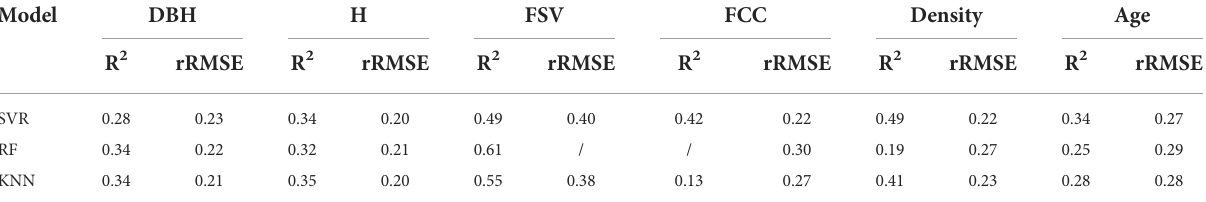
TABLE 7 The R 2 and rRMSE of the estimated forest parameters.